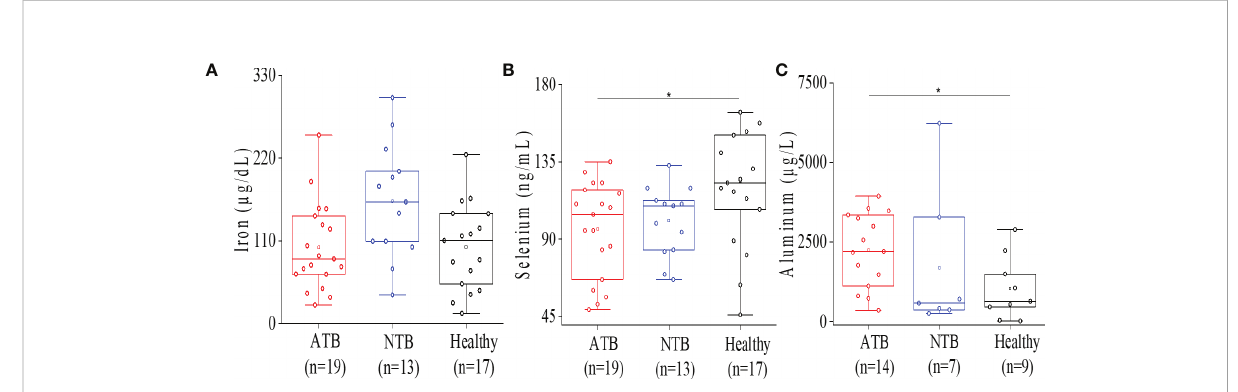
FIGURE 2 Serum ICP-MS analysis showed altered micro elemental pro fi le in ATB patients. Box plot representation for iron levels in ATB, NTB, and healthy groups (A) . Box plot representation for selenium levels in ATB, NTB, and healthy groups (B) . Box plot representation for aluminum levels in ATB, NTB, and healthy groups (C) (* p <